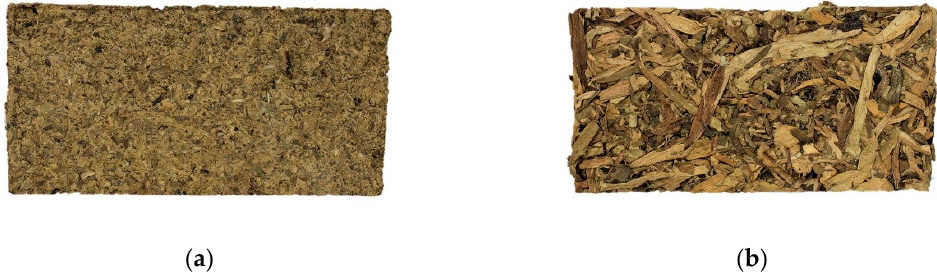
Figure 2. Manufactured Binder-Less WHP panels: ( a ) pulp WHP: Panel made with pulp (WHP passing through #2 sieve, R20); ( b ) staple WHP: Panel made with staple (WHP retained on #2 sieve, R20).